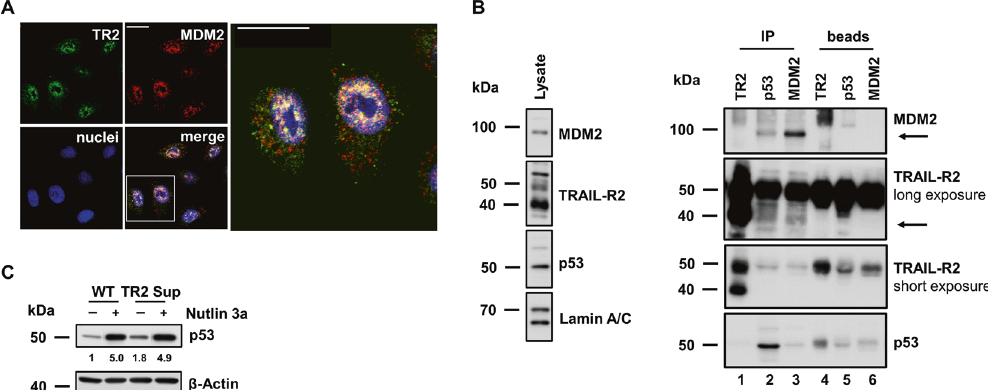
Fig. 5 TRAIL-R2 co-localizes and co-precipitates with MDM2. A Intracellular distribution of TRAIL-R2 and MDM2 studied in A549 cells by indirect immuno fl uorescence followed by confocal LSM using Lexatumumab (anti-TRAIL-R2, Lexa) and sc-965 (anti-MDM2). Scale bar 20 µm. B TRAIL-R2, p53 and MDM2 were immunoprecipitated from nuclear fractions of A549 WT cells by speci fi c antibodies [anti-TRAIL-R2 antibody (HS201); anti-p53 antibody (DO-1); anti-MDM2 antibody (sc-965)]. Nuclear lysates and precipitated protein complexes were examined by western blotting using following antibodies: anti-TRAIL-R2 antibody (2019); anti-p53 antibody (FL393) and anti-MDM2 antibody (86934). Lamin A/C was analyzed in parallel as a marker for the nuclear fraction. C A549 WT and TRAIL-R2 Sup cells were treated with Nutlin 3a (5 µM) for 24 h. Whole cell lysates were analyzed by western blotting for the expression of p53 using DO-1 antibody. The level of β -Actin was determined in parallel as loading control. P53 protein level was quanti fi ed by densitometry and normalized to respective β ‐ Actin levels. Data are presented as fold-changes relative to WT